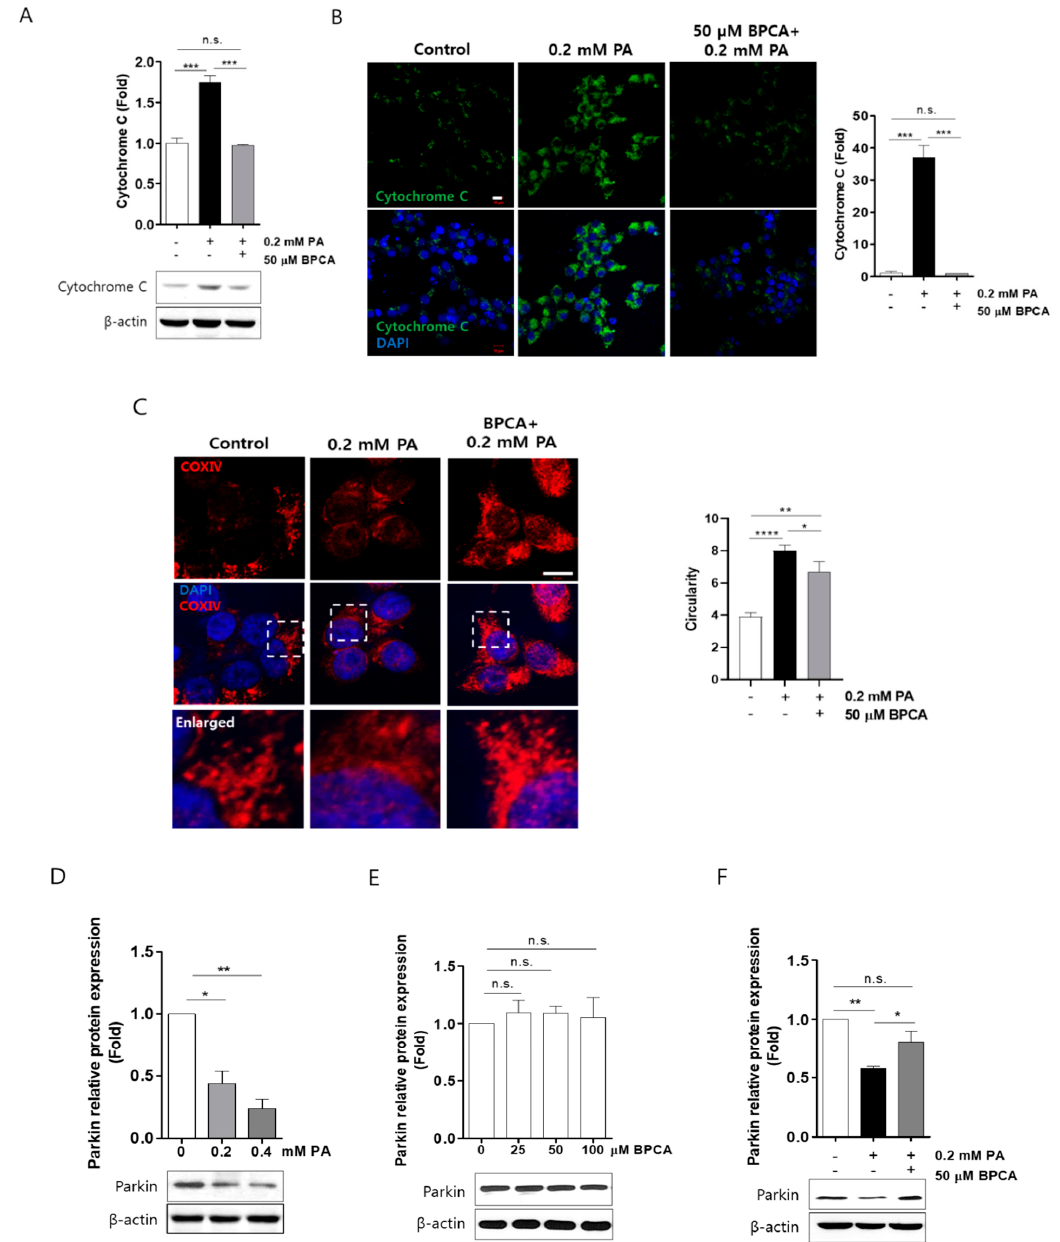
Figure 4. 5-Bromoprotocatechualdehyde (BPCA) isolated from Polysiphonia japonica protects PA-induced degradation of parkin by combating cytochrome C release and morphology alteration of mitochondria in Ins-1 cells. Ins-1 cells were incubated with 50 µ M BPCA for 1 h and then further incubated with/without 0.2 mM PA for 24 h. ( A ) Western blotting was subsequently performed as described in “Materials and Methods”. ( B , C ) Confocal image was subsequently performed as described in “Materials and Methods”. Scale bar: 10 µ m. Circularity measures the average value per high-resolution micrograph using ImageJ. ( D ) Ins-1 cells were incubated with the indicated concentrations of PA (0.2 and 0.4 mM) for 24 h. ( E ) Ins-1 cells were incubated with the indicated concentrations of BPCA (25, 50, and 100 µ M) for 24 h. ( F ) Ins-1 cells were incubated with 50 µ M BPCA for 1 h and then further incubated with/without 0.2 mM PA for 24 h. Western blotting was subsequently performed as described in “Materials and Methods”. * p < 0.05, ** p < 0.01, *** p <0.005, **** p <0.001, n.s. = no